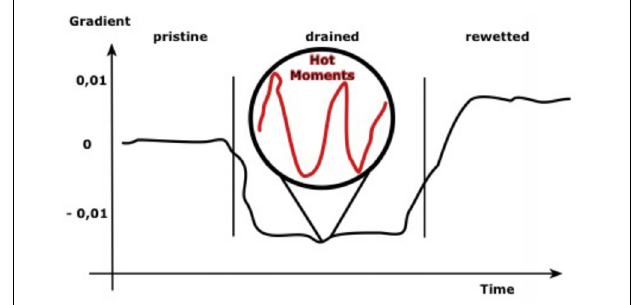
FIGURE 6 | Schematic of average land-to-sea gradients in coastal peatlands under different water management scenarios. Irrespective of the general situation, extreme events may cause higher gradients than expected.